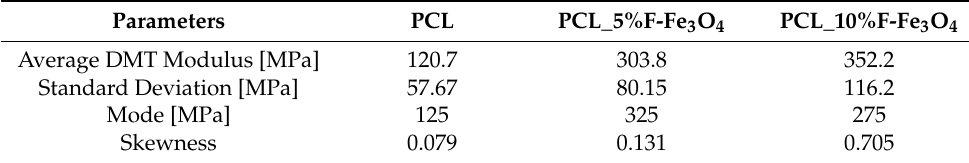
Figure 6. DMT frequency values of: ( a ) PCL_0%F-Fe 3 O 4 ; ( b ) PCL-5%F-Fe 3 O 4 ; ( c ) PCL-10%F-Fe 3 O 4 . Table 4. Statistical parameters of local mechanical value distribution.